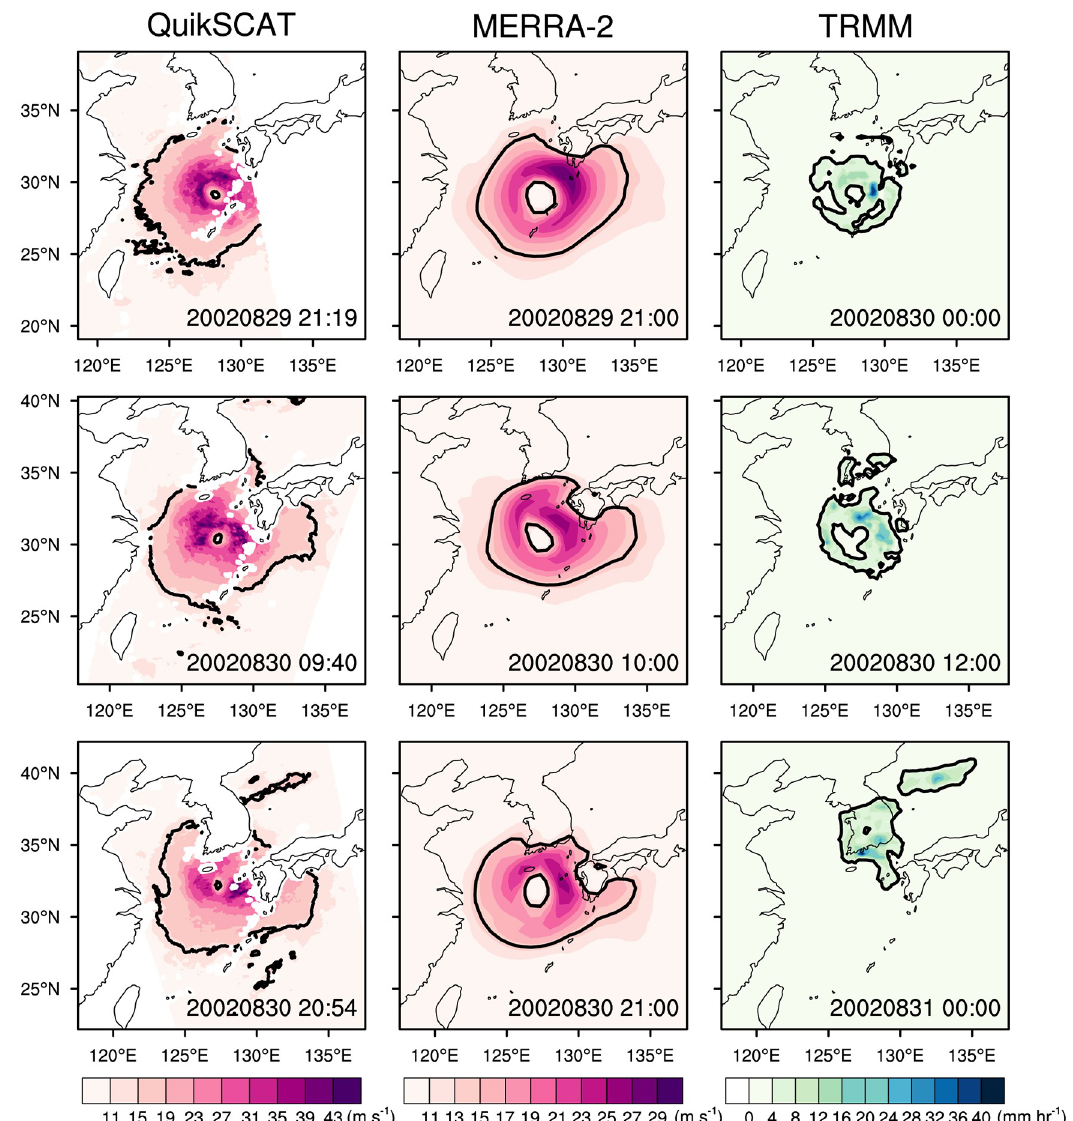
Fig 2. Spatial distribution of wind speed (unit: m s -1 ) at 10-m level, and precipitation rate (unit: mm hr -1 ) for the RUSA (2002) obtained from the QuikSCAT version 3 (left), MERRA-2 (middle), and TRMM-3B42 (right) data, respectively. The time of the MERRA-2 and TRMM-3B42 data is selected to be closest to that of the QuikSCAT data. Black contour lines indicate the region where wind speed and precipitation rate is 14 m s -1 and 3.33 mm hr -1 ,